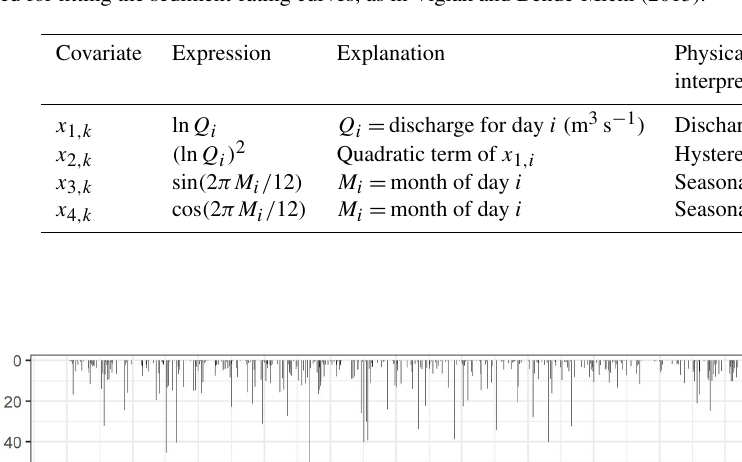
Table 1. Covariates used for fitting the sediment-rating curves, as in Vigiak and Bende-Michl (2013).